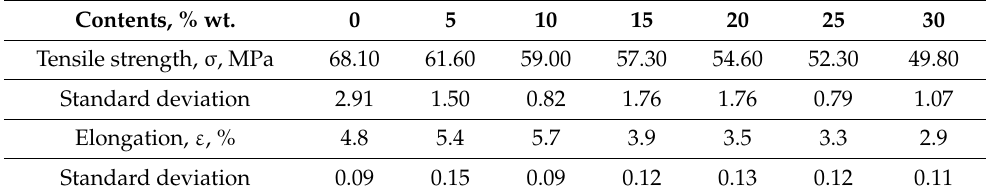
Table 5. Changes in the mass of samples depending on the content of the Crusil M20 filler. Filler Content, %wt.